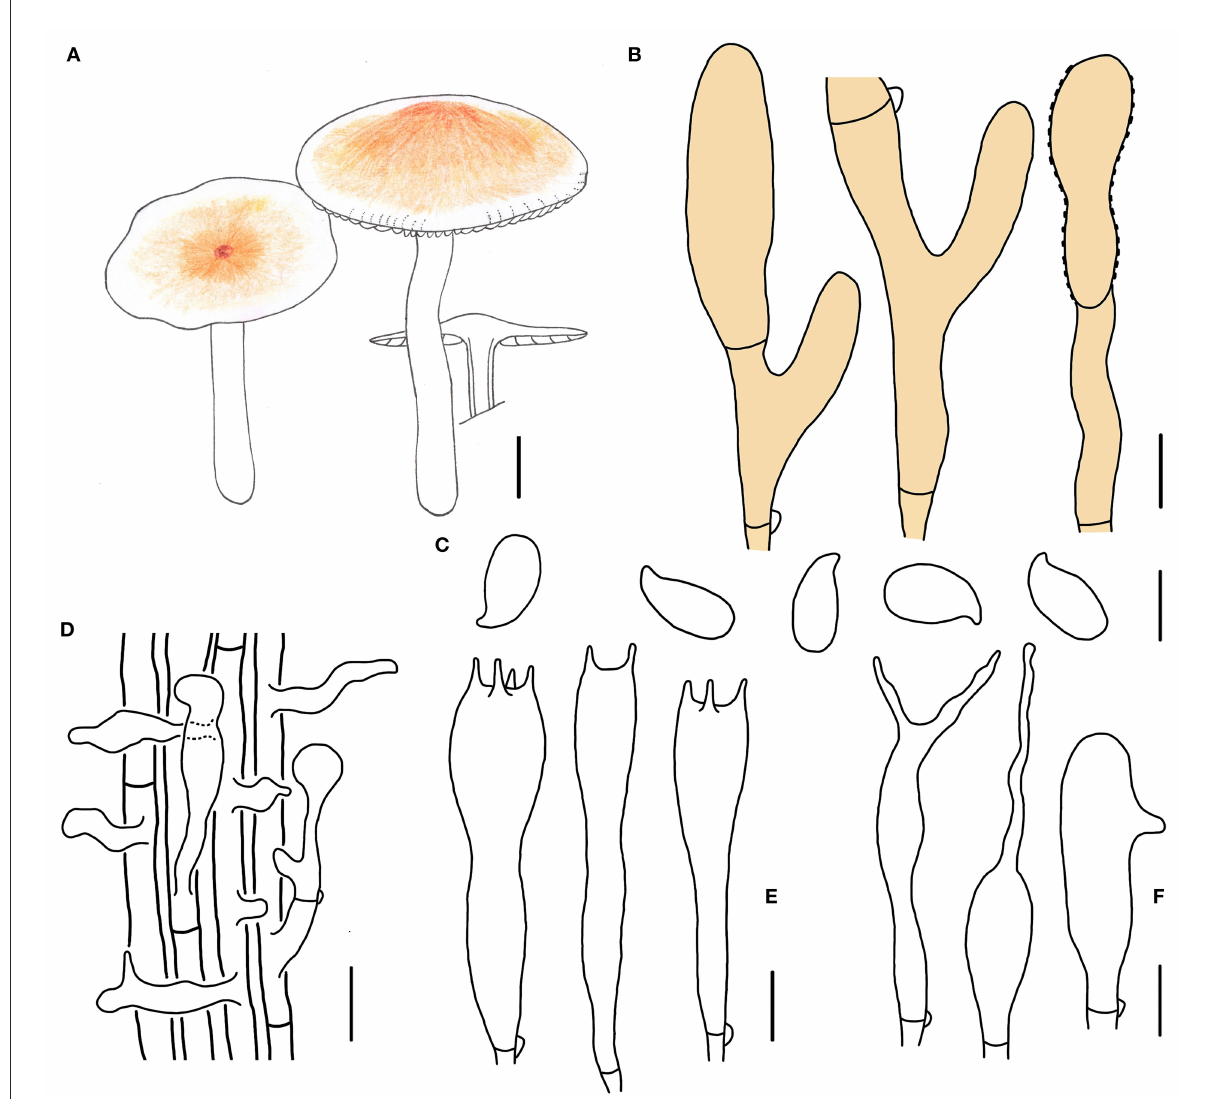
FIGURE5 Morphological characteristics of Gymnopus subdensilamellatus (HMJAU 60997, holotype). (A) Basiaiomata; (B) Pileipellis elements; (C) Basidospores; (D) Caulocystidia; (E) Basidia; (F) Cheilocystidia; Scale bars: 1cm (A) ; 10 µ m (B) ; 20 µ m (D) ; 5 µ m (C,E,F)